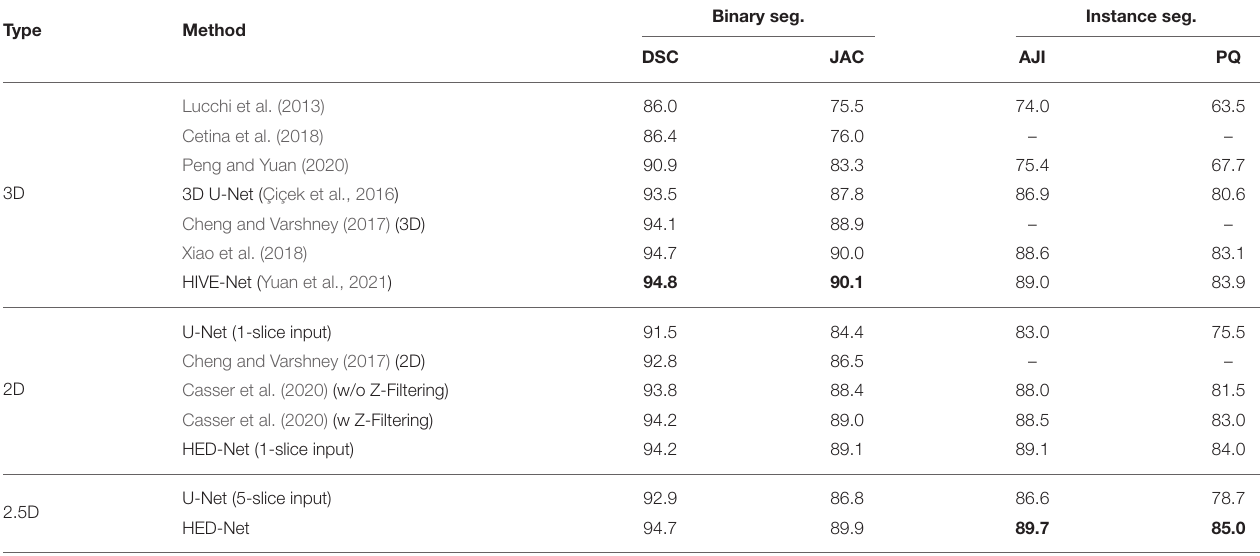
The evaluation results under measures (%) for binary segmentation and instance segmentation. Best results are highlighted in bold.